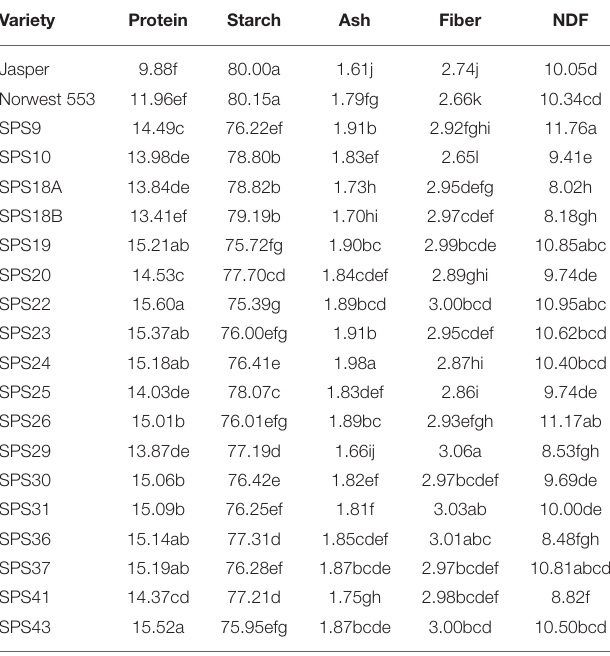
Means followed by the same letter within columns are not significantly different at α < 0.05. TABLE 13 | Protein (%), starch (%), ash (%), crude fiber (%), and neutral detergent fiber (NDF, %) at the Tukey